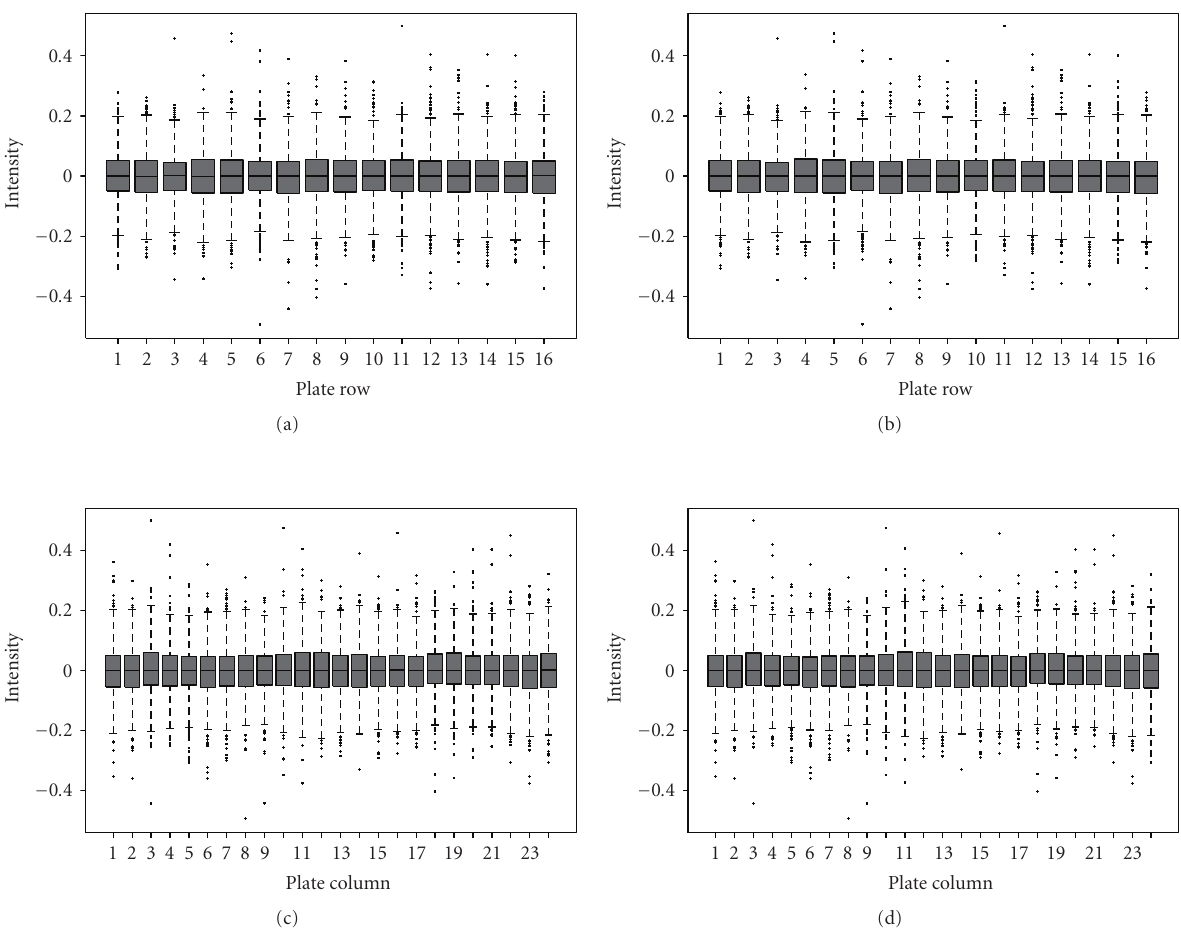
Figure 8: Spotting process: plate row/column: the box-plot showing the distribution of log T/C values for each plate row (a) before correction and (b) after correction by median subtraction and for each plate column (c) before correction and (d) after correction by median subtraction.